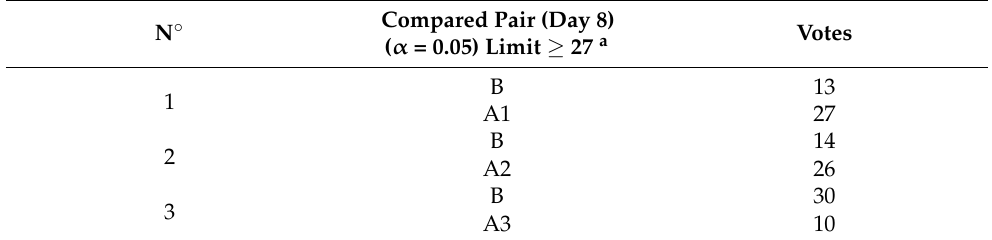
Table 3. Results of the visual panel for samples with different antioxidant